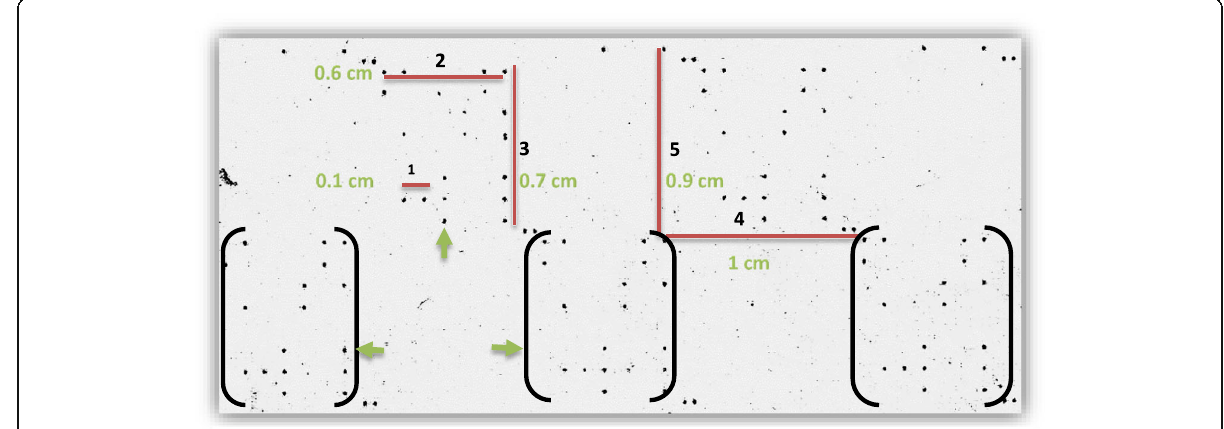
Fig. 9 The constant five measurements carried out on the basic repeated coded dot matrix model of the color laser printer of Ricoh ®